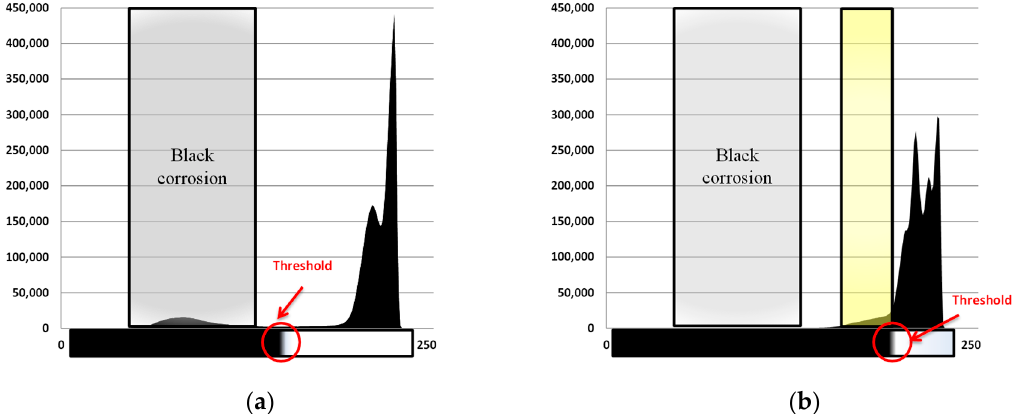
Figure 6. Histogram image of a corroded sample with black corrosion ( a ) and yellow corrosion ( b ).